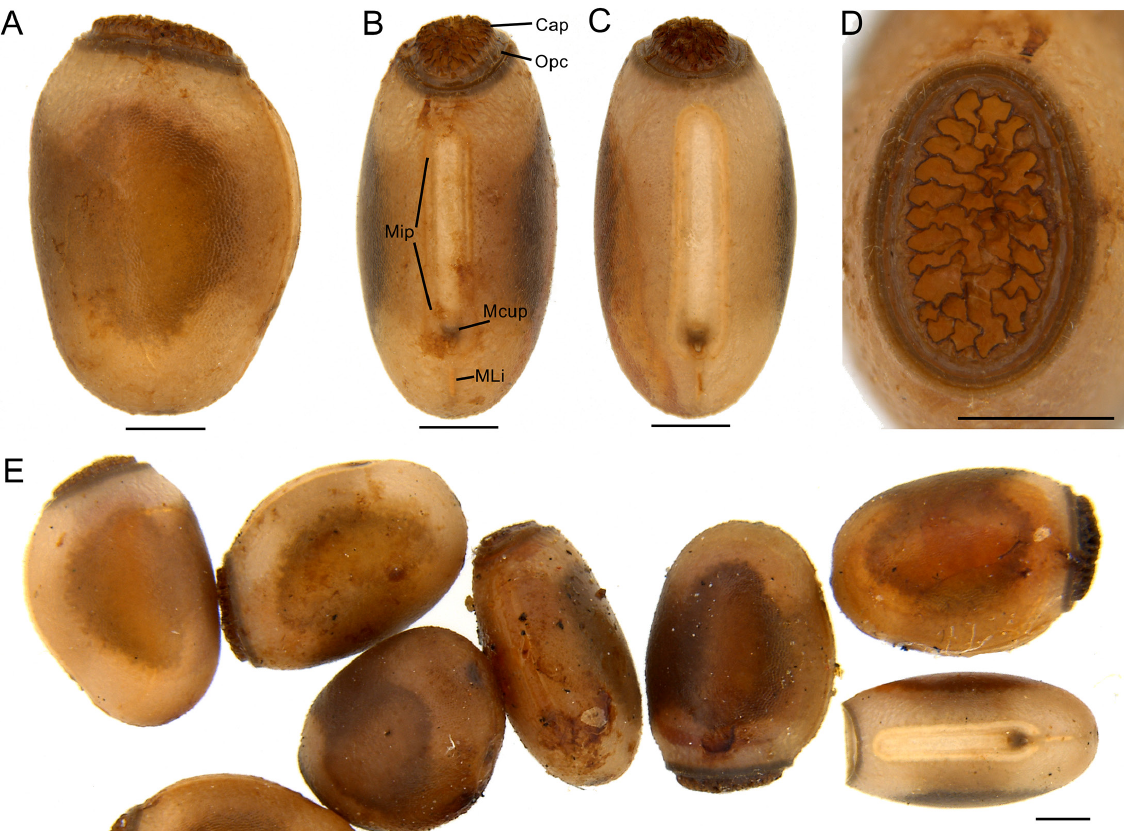
Fig. 24. Arumatia crassicercata Ghirotto, Crispino & Engelking gen. et sp. nov., egg morphology from female paratypes. A . Lateral view. B–C . Dorsal view. D . Detail of operculum, anterior view. E . Several eggs together. Abbreviations: Cap = capitulum; Mcup = micropylar cup; Mip = micropylar plate; MLi = median line; Opc = operculum. Scale bars: 0.5